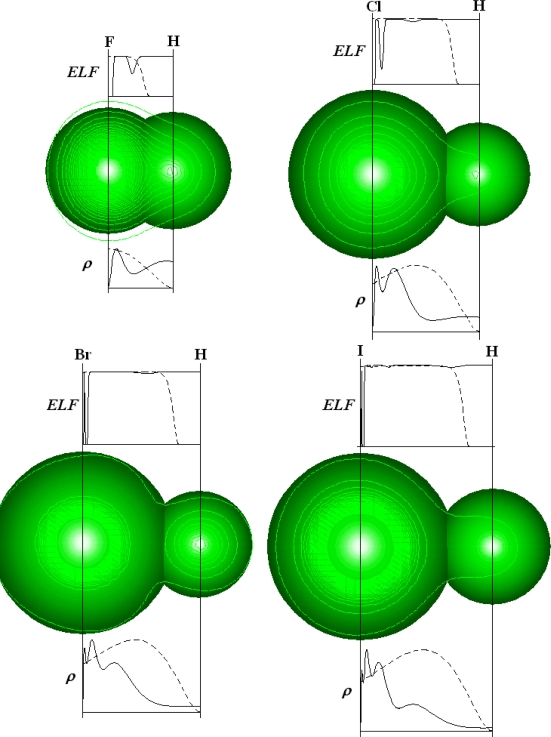
Comparative analysis of the charge density contours, electronic localization functions (ELFs), and radial densities for the H (dashed lines), F, Cl, Br, and I (full lines) atoms in molecular combinations HF, HCl, HBr, and HI, respectively [24].